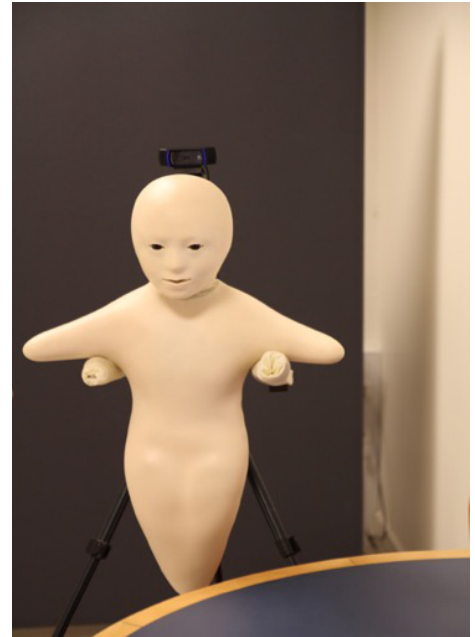
Figure 1: The Telenoid